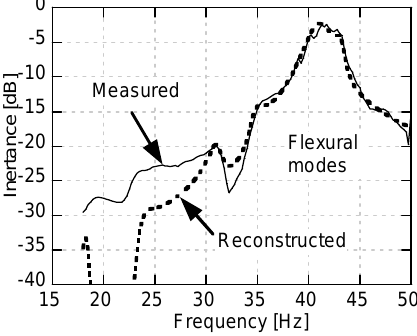
Fig. 11. RE-FC, FRF of point P on the